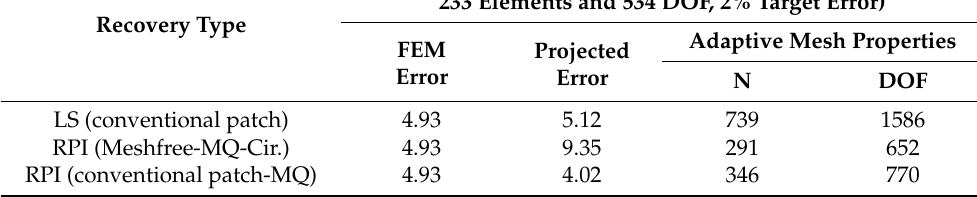
Table 9. Adaptive finite element analysis results (errors, total number of elements (N) and DOF) for incompressible-elastic plate with 2% target error using quadrilateral